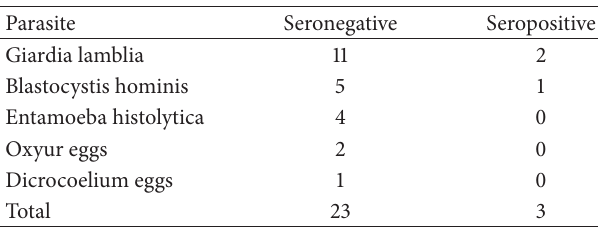
Table 2: Parasites found in samples after stool examination by using wet mount and formalin-ethyl acetate technique. Parasite